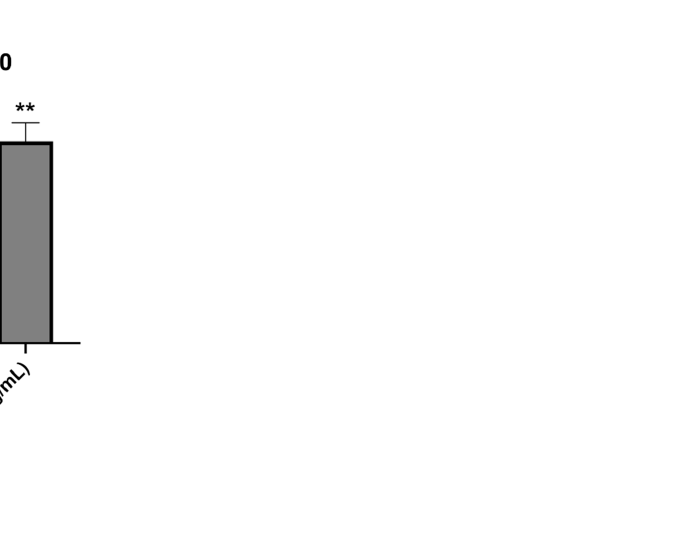
Figure 7. CNT + rfhSP-D treated AML14.3D10 cells show upregulation of the mRNA transcript levels Figure 7. CNT+rfhSP ‐ D treated AML14.3D10 cells show upregulation of the mRNA transcript levels of p53. AML14.3D10 (0.4 × 10 6 ) cells were treated with CNT+rfhSP ‐ D or rfhSP ‐ D alone, along with of p53. AML14.3D10 (0.4 × 10 6 ) cells were treated with CNT + rfhSP-D or rfhSP-D alone, along with an untreated control (cells+CNT) (20 μ g/mL each). The RQ value was calculated using the formula: Int. J. Mol. Sci. 2021 , 22 , x FOR PEER REVIEW an untreated control (cells + CNT) (20 µ g/mL each). The RQ value was calculated using the formula: RQ = 2 − ΔΔ Ct. * p < 0.05 and ** p < 0.01 compared to CNT only group. RQ = 2 − ∆∆ Ct. * p < 0.05 and ** p < 0.01 compared to CNT only group. 2.6. Apoptosis Induction in AML14.3D10 and K562 Cells by rfhSP ‐ D ‐ CNT via Intrinsic Path ‐ way Since apoptosis can be initiated via intrinsic or extrinsic pathways, expression of caspases was examined in AML14.3D10 or K562 cell lines treated with CNT+rfhSP ‐ D (20 μ g/mL) or rfhSP ‐ D alone (20 μ g/mL), using a fluorogenic substrate to detect the activation of caspase 3 and 7 (Figure 8). Higher levels of caspase 3 and 7 were observed in CNT+rfhSP ‐ D treated AML14.3D10 (Figure 8A) and K562 (Figure 8B) cells, when com ‐ pared to rfhSP ‐ D or CNT alone ‐ treated cells. There was a time ‐ dependent increase in caspase 3 and 7 activation, which peaked at 24 h. Cleaved caspase 9 level was observed in CNT+rfhSP ‐ D (or rfhSP ‐ D ‐ treated) AML14.3D10 or K562 cells at 12h, reflecting an intrin ‐ sic pathway (Figure 9).